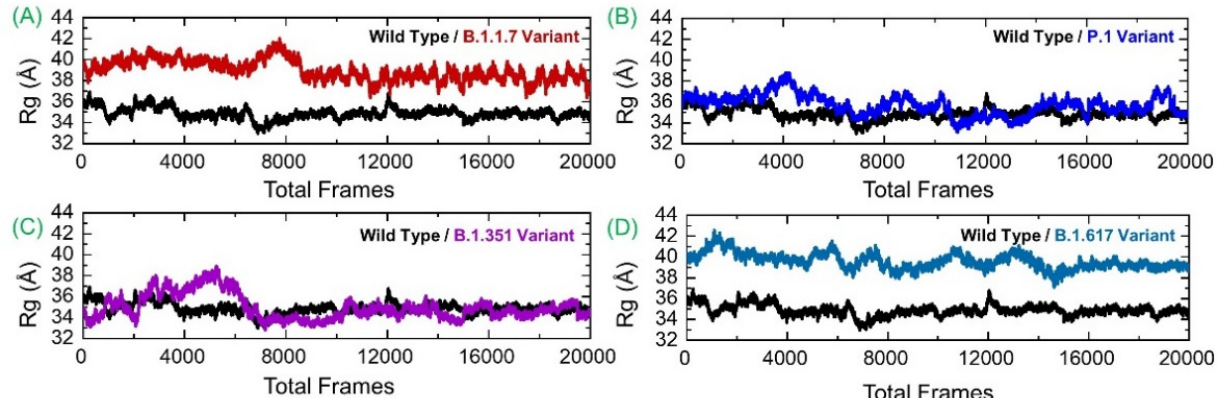
Figure 6. Structural compactness of GRP78 and spike RBD of the wild-type and variants calculated as Rg. ( A ) shows the Rg of wild-type-RBD-GRP78 complex; ( B ) shows the Rg of B.1.17-RBD-GRP78 complex; ( C ) shows the Rg of P.1-RBD-GRP78 complex; ( D ) shows the Rg of B.1.351-RBD-GRP78 complex.